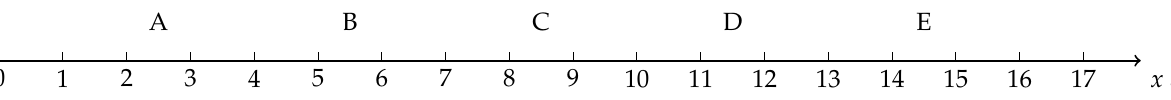
Figure 2. Geometry of a 1D slice taken through a fuel assembly. Regions A, B, C, D and E contain guide-tubes that can have control rods inserted. All other regions contain fuel rods with fissionable